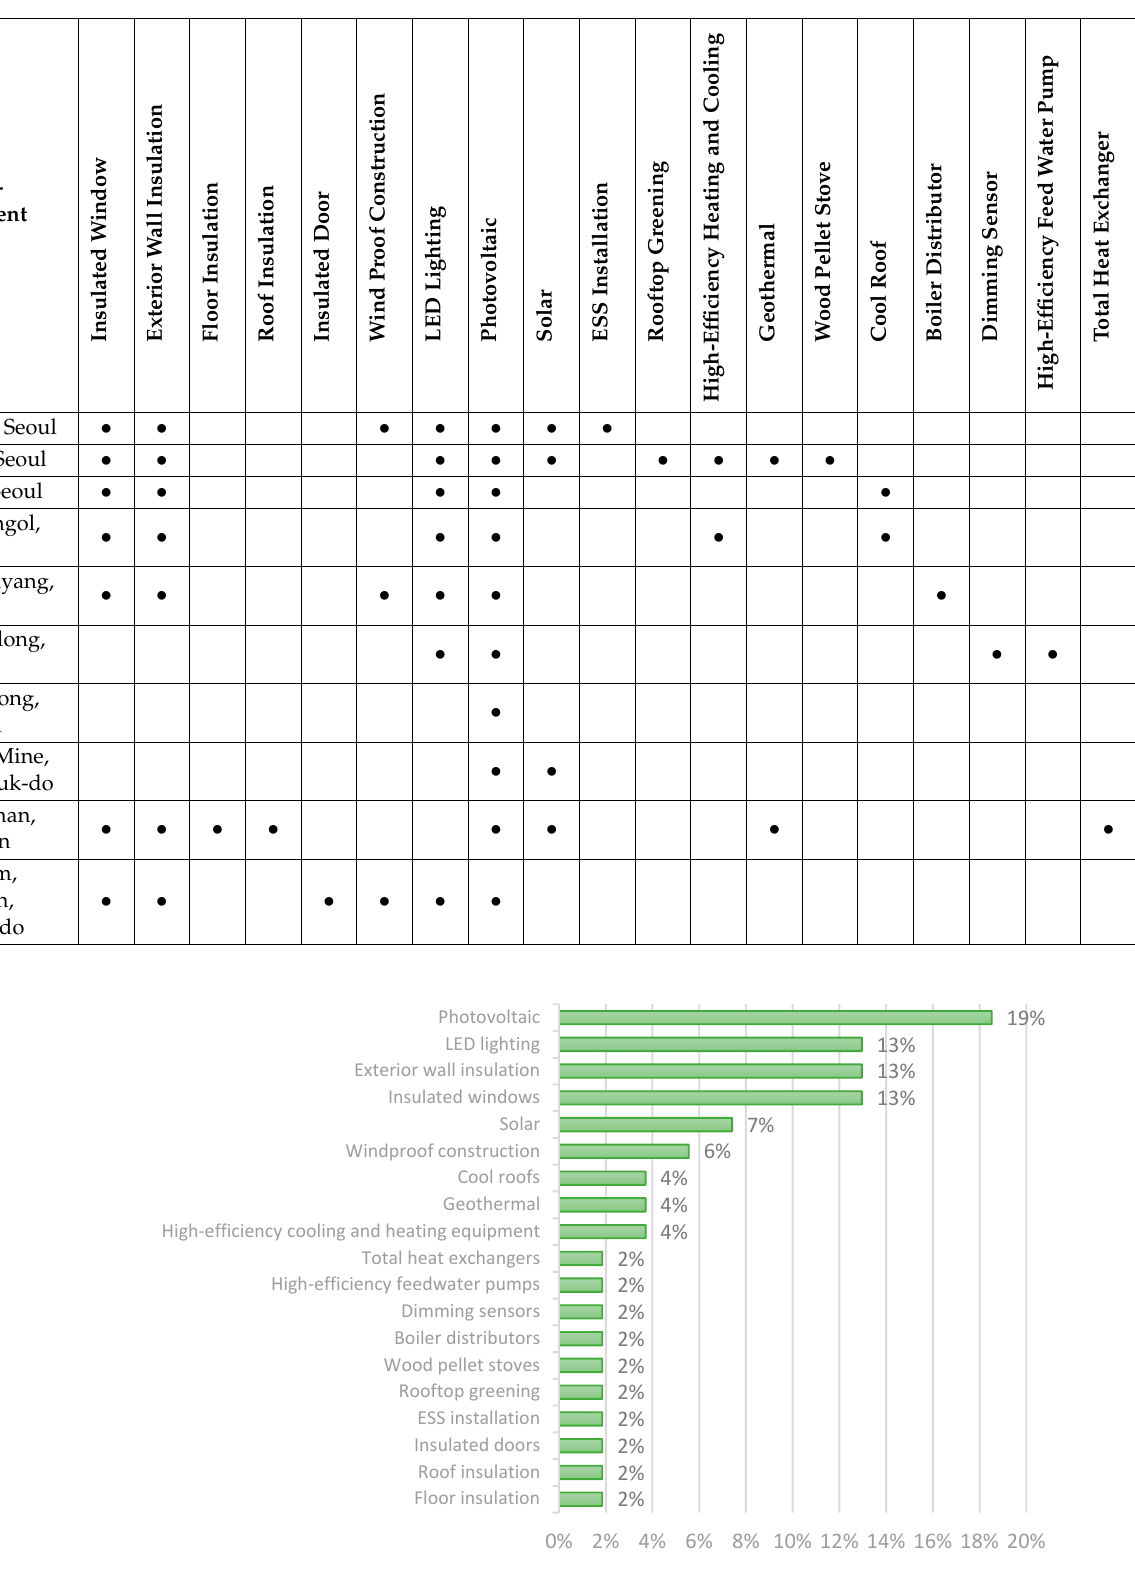
Figure 4. Percentages of the applied technologies for green remodeling of aging buildings in urban regeneration projects in South Korea.